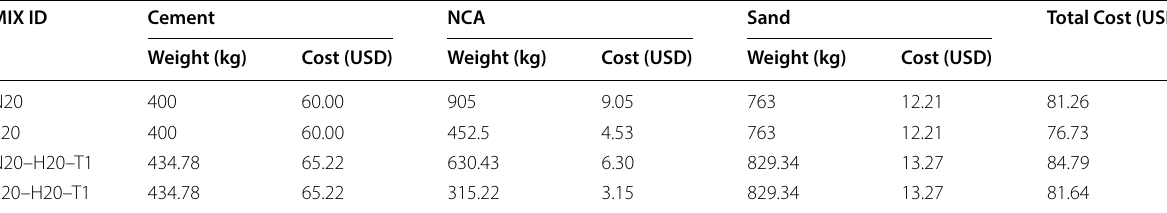
Table 4 Cost of raw material of four representative